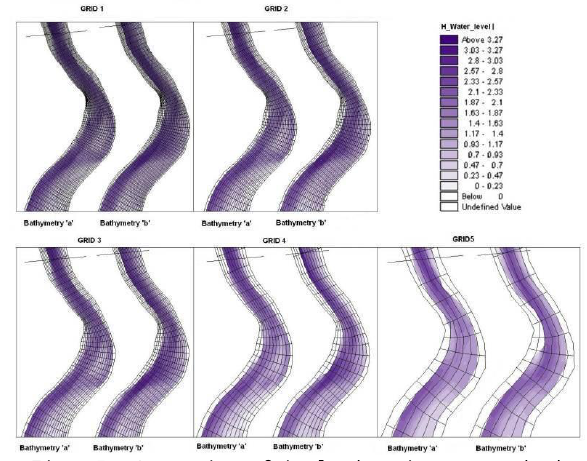
Figure 5. Comparison of simulated maximum water depth with different topographical resolutions (bathymetries „a‟-„b‟) and cell sizes (grids 1 to 5)